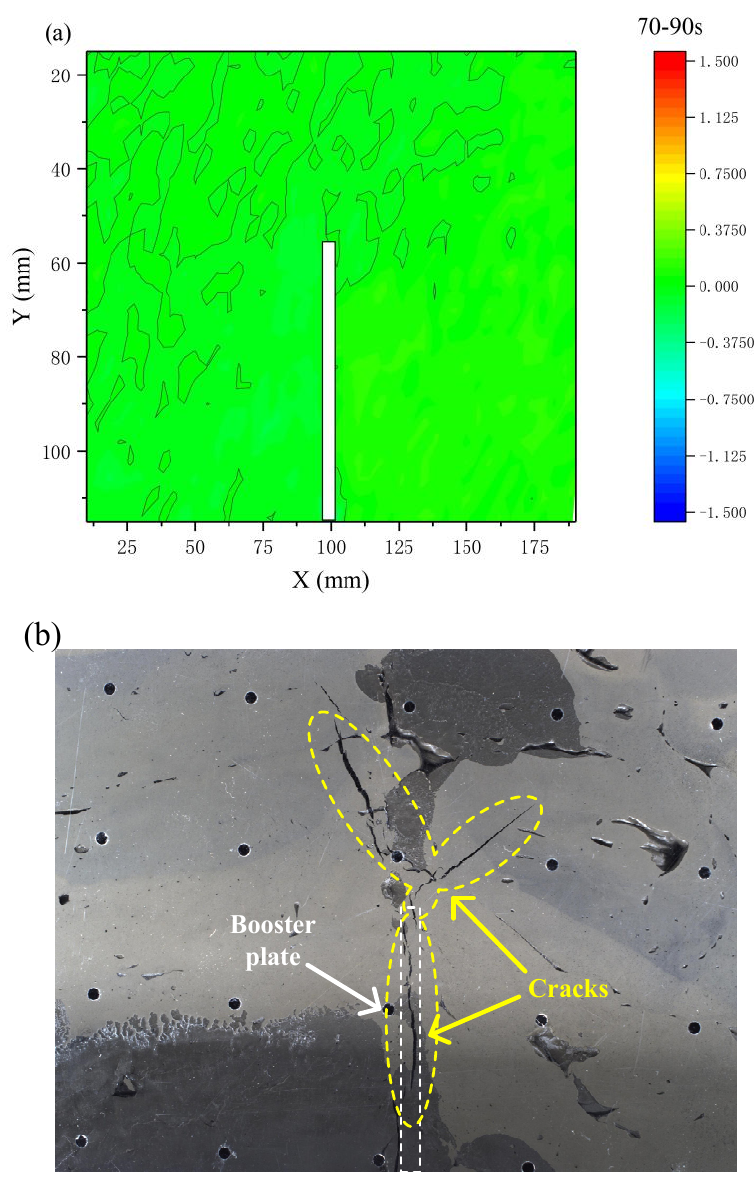
Figure 12. PIV results for a time period of 70~90 s of air boosting: ( a ) coloured contour on horizontal displacement; ( b ) slurry picture taken on time instant t * = 90 s